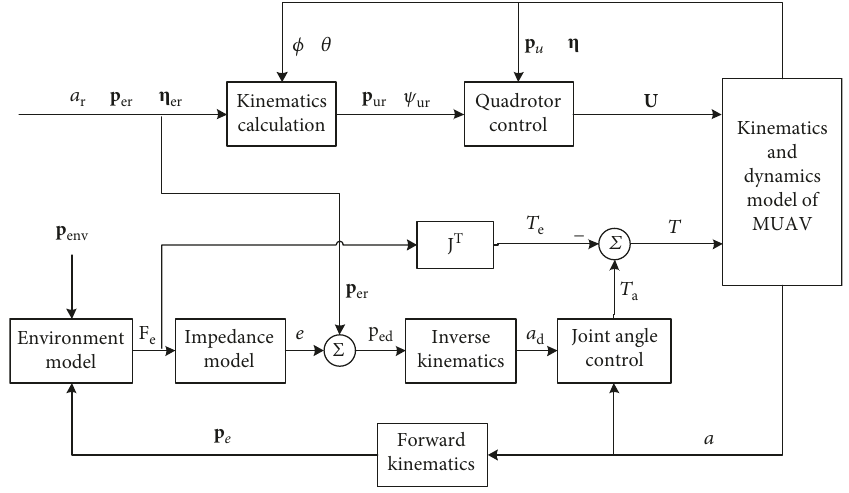
Figure 8: The impedance control block diagram.